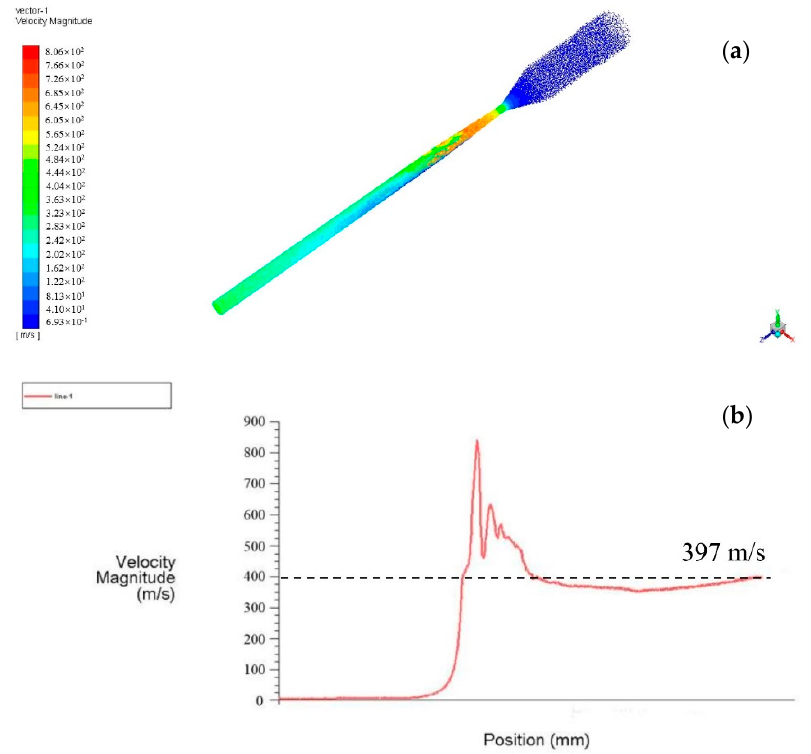
Figure 8. ( a ) The velocity distribution diagram of powder particles in the Laval tube; ( b ) the velocity–position curve of the powder particles in the Laval tube.